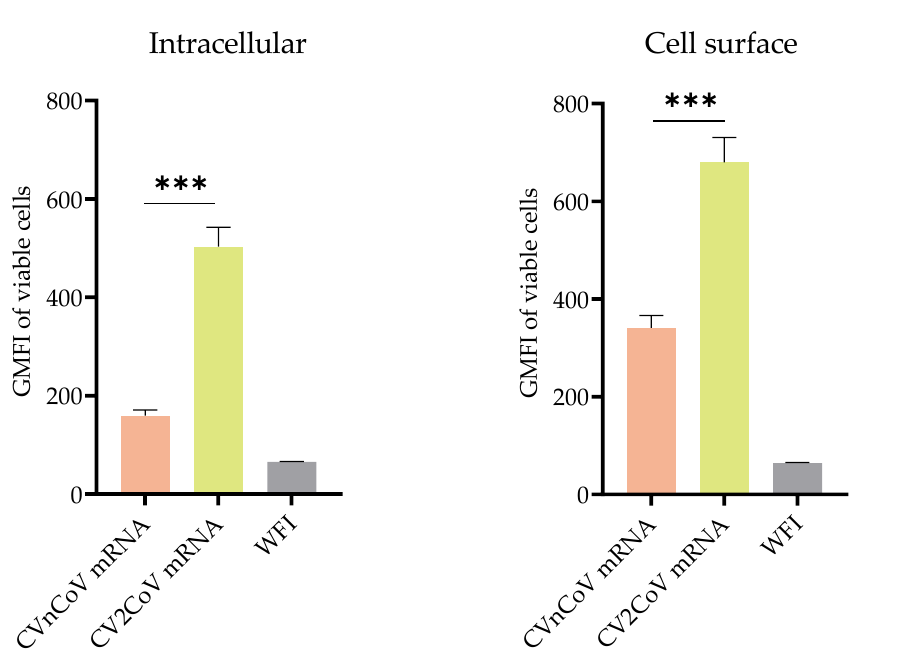
Figure 1. Comparison of protein expression induced by CVnCoV and CV2CoV mRNA. Expression of SARS-CoV-2 spike (S) protein in HeLa cells transfected with CVnCoV or CV2CoV mRNA, as indicated, detected using flow cytometric analysis via an S-specific antibody either with or without membrane permeabilisation, allowing detection of intracellular and cell surface expression, respectively. The geometric mean fluorescence intensity (GMFI) is expressed as mean + standard deviation (SD) of duplicate samples from two independent experiments. *** = p < 0.001 ( t -test). WFI: water for injection.